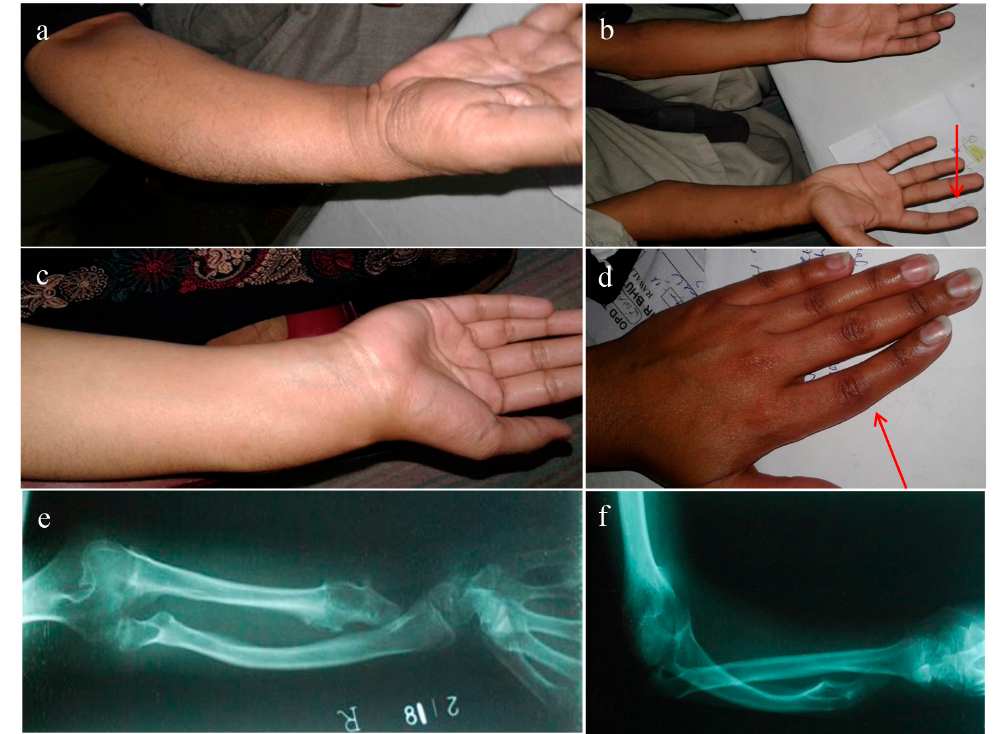
Figure 2. Clinical manifestation of HME family. ( a ) Patient II:4 is representing varus deformities and radial bowing due to ulnar shortening. ( b ) Patient III:4, demonstrating limbs malalignment, limbs length discrepancy along with cubitus valgus deformity at elbows with limited joints movement and clinodactyly. ( c ) Patient III:5 with varus deformities of the elbow. ( d ) Patient III:5 shows clinodactyly as pointed by arrow. ( e , f ) Radiological examination of patient III:4 showing ulnar shortening, radial bowing and dislocated radioulnar joints